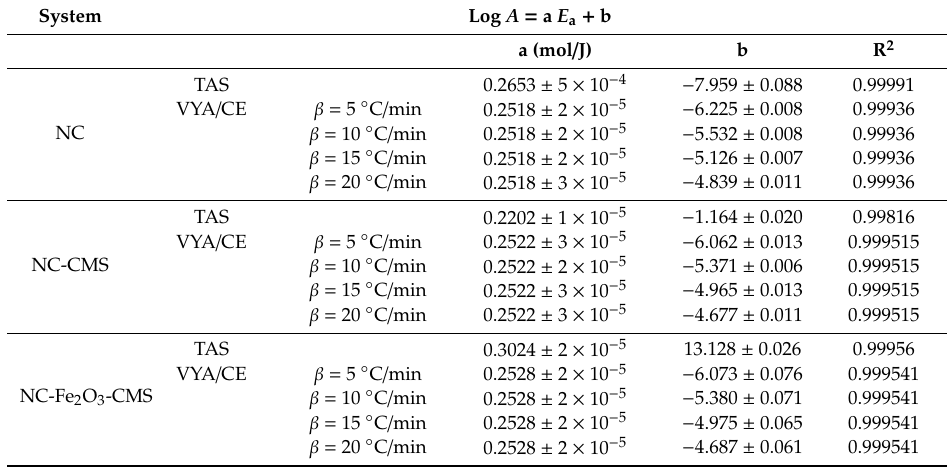
Table 3. Compensation parameters obtained by the Trache–Abdelaziz–Siwani (TAS) method and Vyazovkin’s equation (VYA /